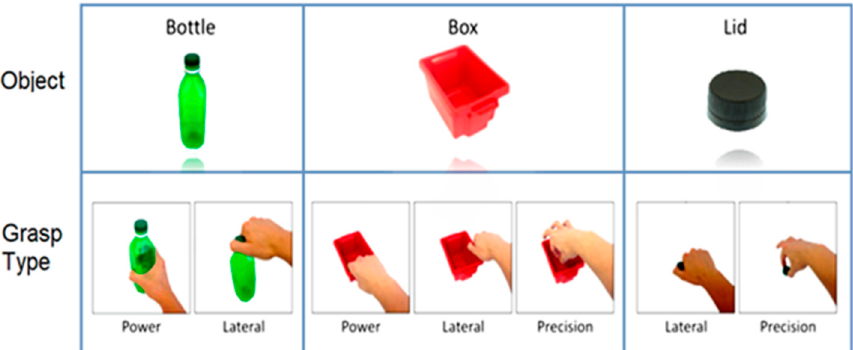
Figure 2. Three objects and seven grasp types used for the experiment. Twenty images are taken from various viewpoint angles for each object to construct the training dataset. The bottle was grasped using power and lateral grasps. The box was grasped using power, lateral, and precision grasps. The lid was grasped using lateral and precision grasps.